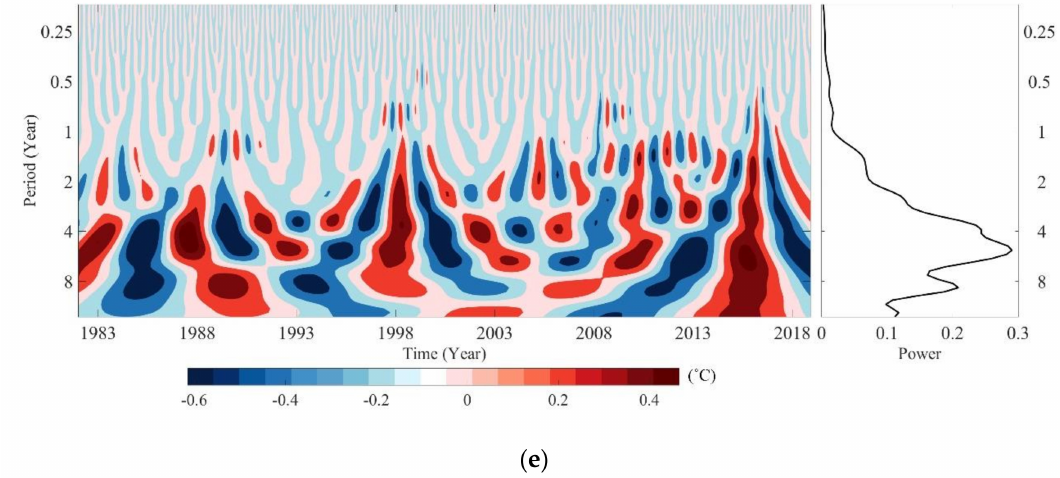
Figure 8. Wavelet transform spectrum and corresponding mean power of the seasonal cycles removed series of ( a ) Size variation; ( b ) Zonal center movement; ( c ) Meridional center movement; ( d ) Maximum SST; ( e ) Mean SST of the